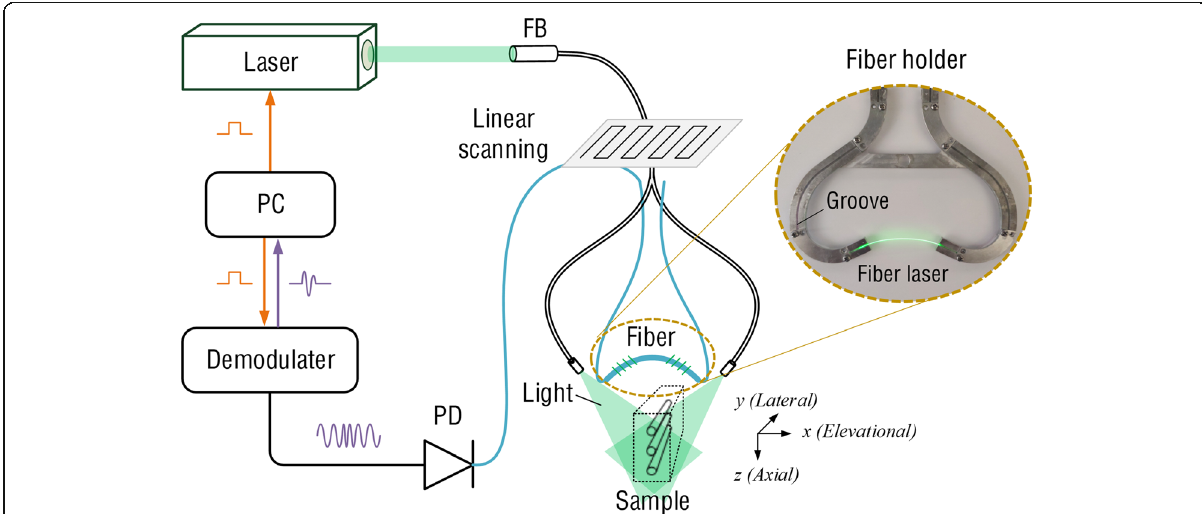
Fig. 1 Schematic of a linear-scanning PAT system with a focused fiber-laser ultrasound transducer: FB, fiber bundle; PC, personal computer; PD,